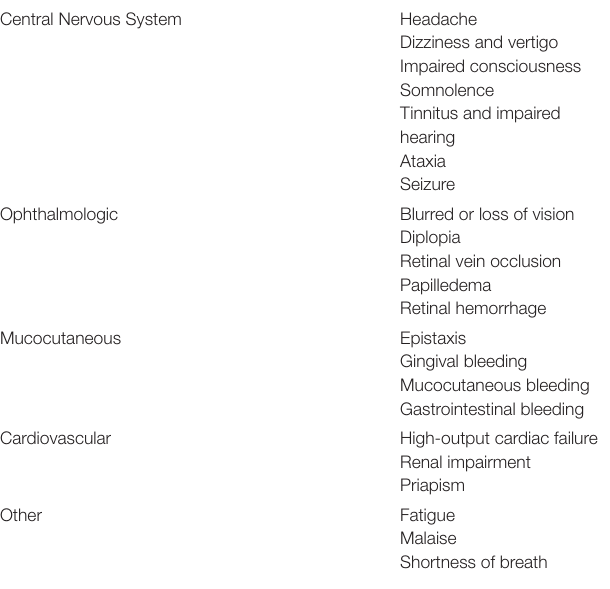
TABLE 1 | Clinical manifestations of hyperviscosity